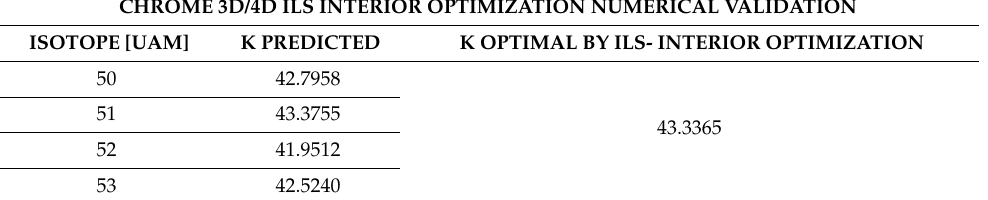
Table 8. 3D/4D ILS interior optimization numerical validation program numerical results for chrome isotope effect model. For UAM, the errors decrease.